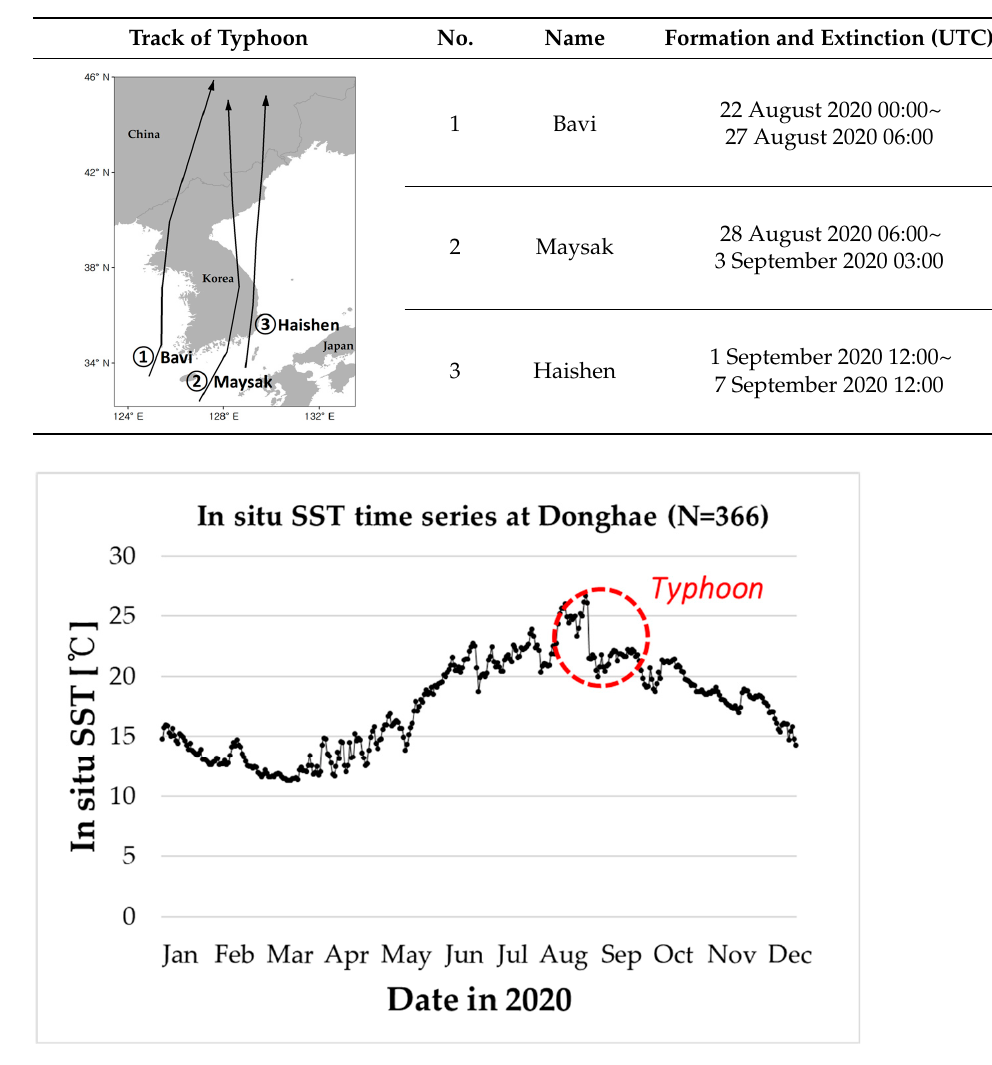
Figure 18. The in situ SST measurements at Donghae in 2020. A sharp decrease from 26.13 °C to 21.52 °C occurred due to typhoons.